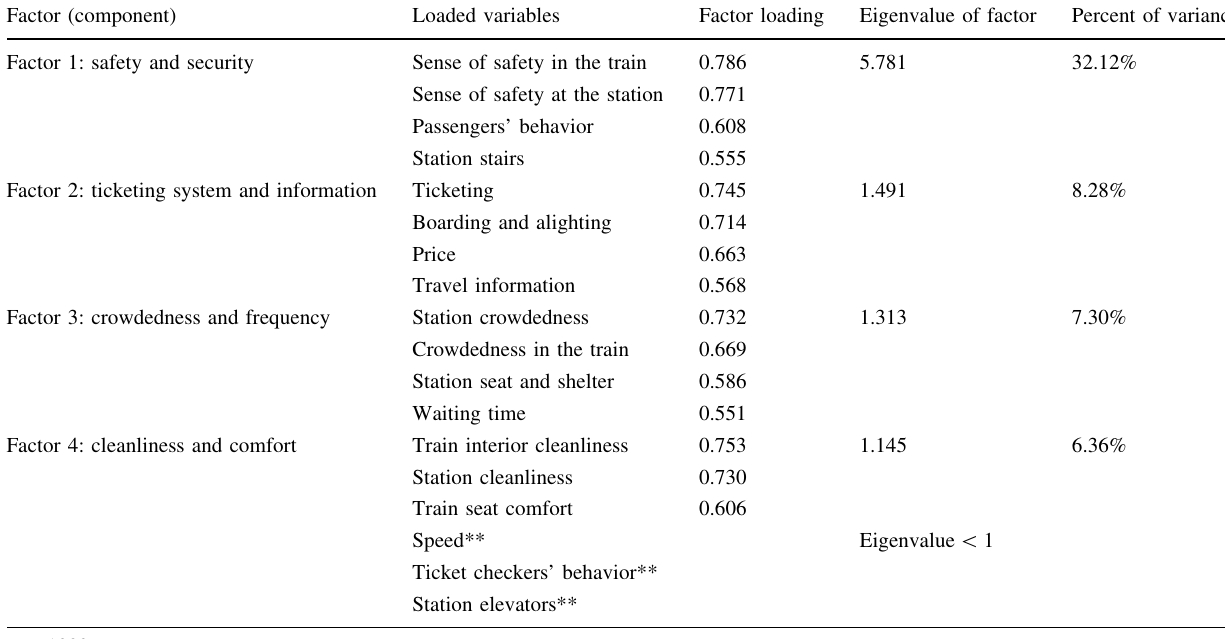
Table 2 Factor analysis results of 18 service quality attributes Factor